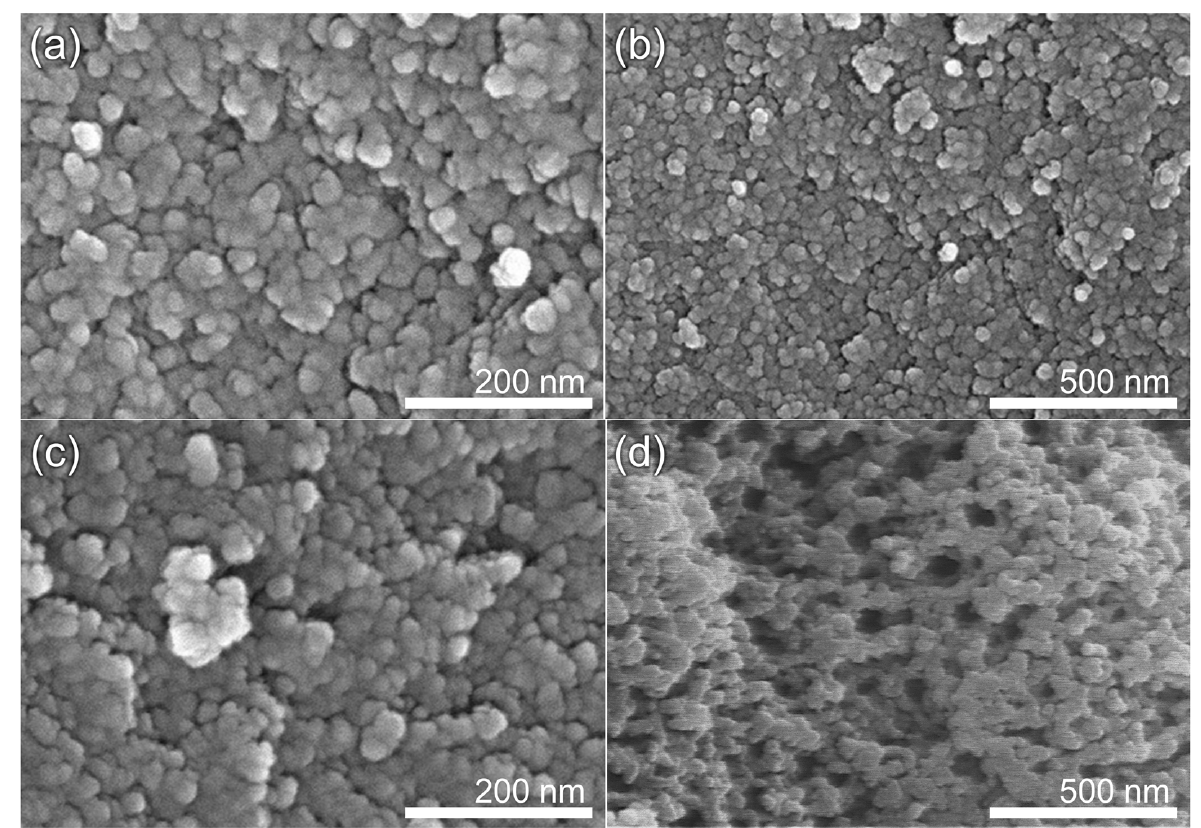
Figure 2. SEM images of CA and ACA samples: ( a , b ) high- and low-magnification images of CA and ( c , d ) high- and low-magnification images of ACA60.